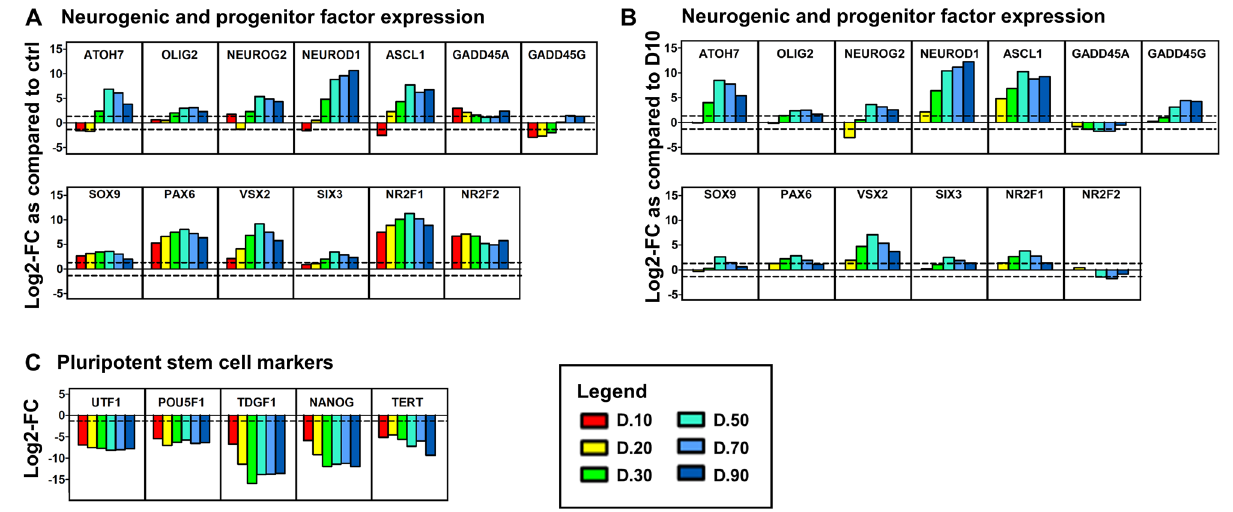
Figure 6. Examination of progenitor, and pluripotent gene expression. Bar graphs show log 2 Fold change (Log 2 FC) in selective gene expression for each CD29 + /CD44 + cell sample as compared to undifferentiated stem cells ( A / C ) or as compared to the D10 isolated cells ( B ). Genes analysed comprise those associated with ( A / B ) neurogenic and progenitor factors and ( C ) pluripotent stem cell markers. We regarded a 1.32 log2 fold change (increase and decrease) the cut off for significant change in expression (corresponds to fold changes of 2.5 and 0.4). Legend shows the age of the organoid to which the CD29 + /CD44 + cells were